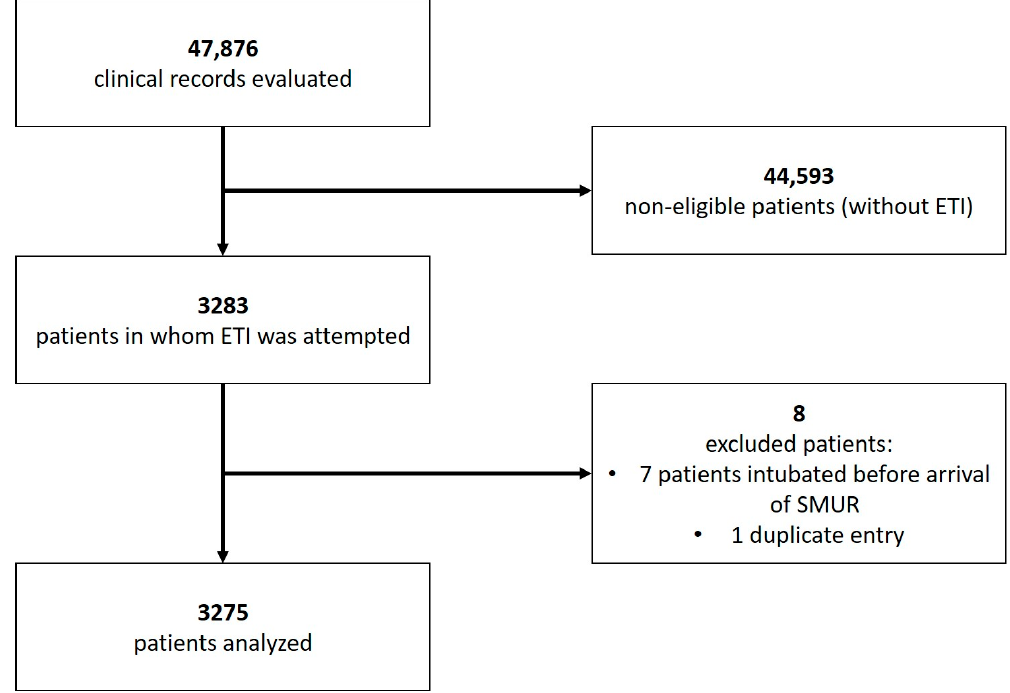
Figure 1. Flowchart of the study.